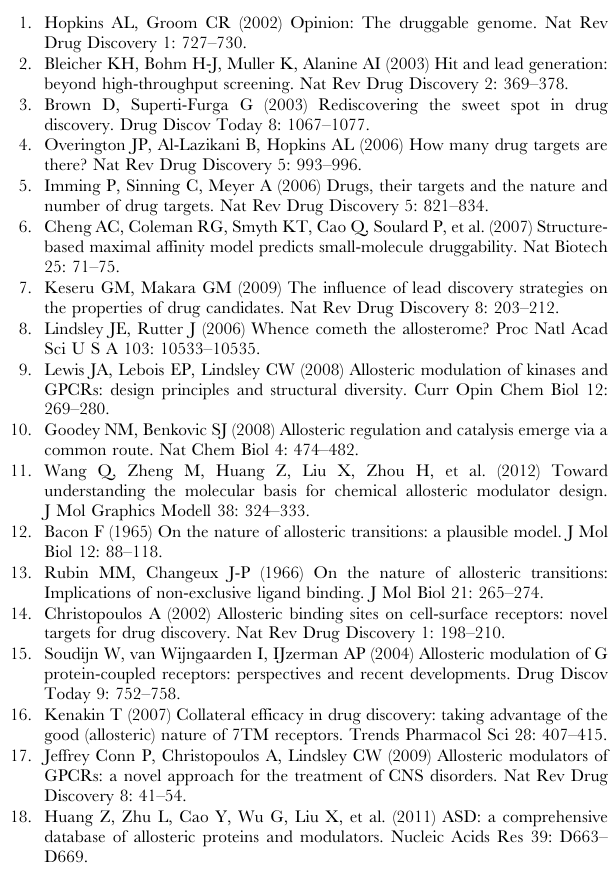
Figure S2 L1 target class distribution of both the allosteric (A) and non-allosteric data (B) sets. Also here the distribution of the target classes differed between the two sets. Figure S3 Bar chart of all the mean values for all descriptors in both the allosteric and non-allosteric set of the 7TM2 class (Class B GPCRs). Note that delimited text files are available on www.gjpvanwesten.nl/ Figure S4 Layout of the online ftp archive with the extra supporting information. Table S1 Physicochemical descriptors used. (DOC) Table S2 Examples of positively enriched allosteric substruc- tures class B GPCR ligands. Table S3 Examples of negatively enriched allosteric substruc- tures class B GPCR ligands. Table S4 Examples of positively enriched non-allosteric sub- structures class B GPCR ligands. (TIF) Table S5 Model improvement when including fingerprints in model construction.